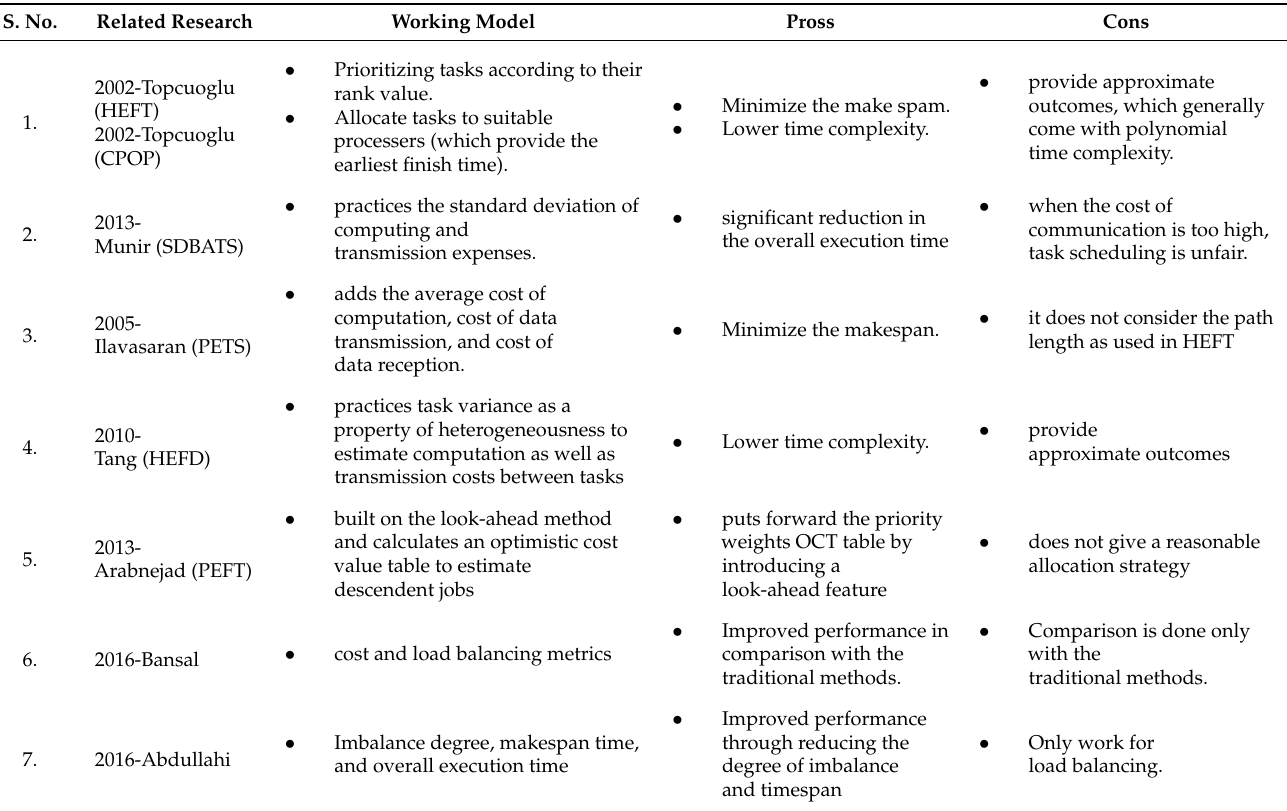
Table 1. Review of task scheduling